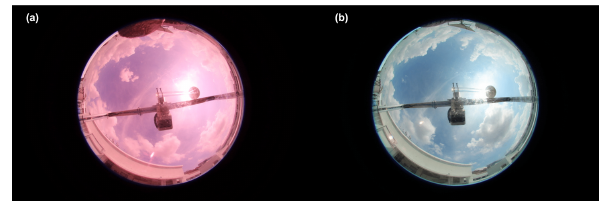
Figure 1. We use custom white balancing to correct the white bal- ance using (a) automatic white balancing and (b) custom white bal-